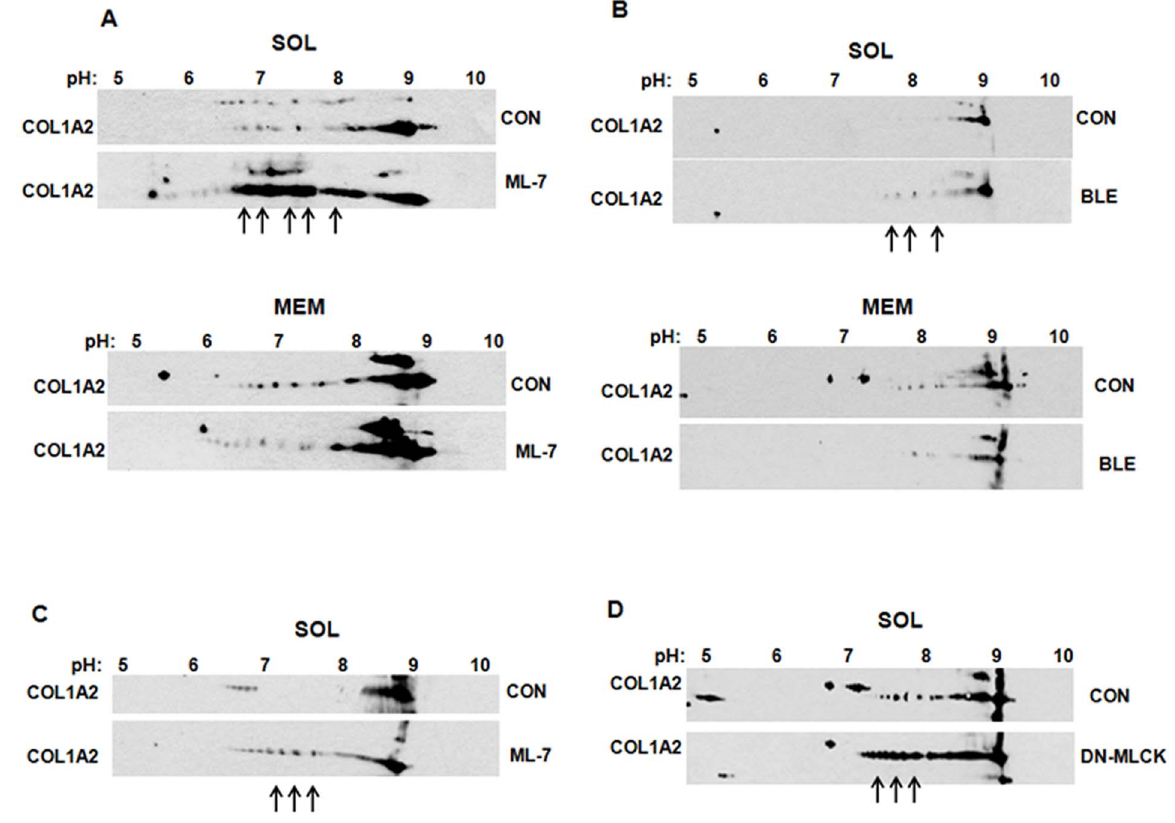
Figure 6. Hypermodifications of collagen a 2(I) polypeptides accumulated in the cytosol after disruption of nonmuscle myosin. A. Modifications of collagen a 2(I) polypeptides accumulated in the cytosol after ML-7 treatment. Control HLFs (CON) and HLF treated with ML-7 were fractionated into cytosolic (SOL) and membrane (MEM) fractions and the fractions were analyzed by 2D SDS-PAGE, followed by western blotting. The pH range of isoelectric focusing strips is shown on the top and excessive modifications of collagen a 2(I) polypeptide are indicated by arrows. B. Same experiment as in A, except the cells were treated with blebbistatin. C. Experiment as in A, except scleroderma skin fibroblasts were used and only cytosolic (SOL) fraction is shown. D. DN-MLCK was overexpressed in HLFs and collagen a 2(I) polypeptide was analyzed in the cytosolic fraction (SOL) of control and DN-MLCK expressing cells by 2D SDS-PAGE and western blotting. Arrows indicate the hypermodifications.